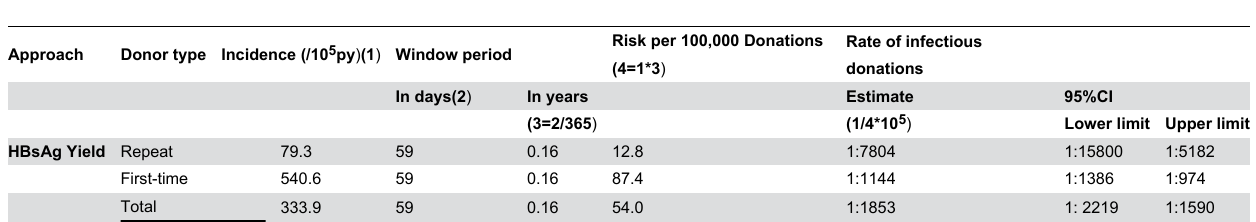
Approach Donor type Incidence (/10 5 py ) (1 ) Window